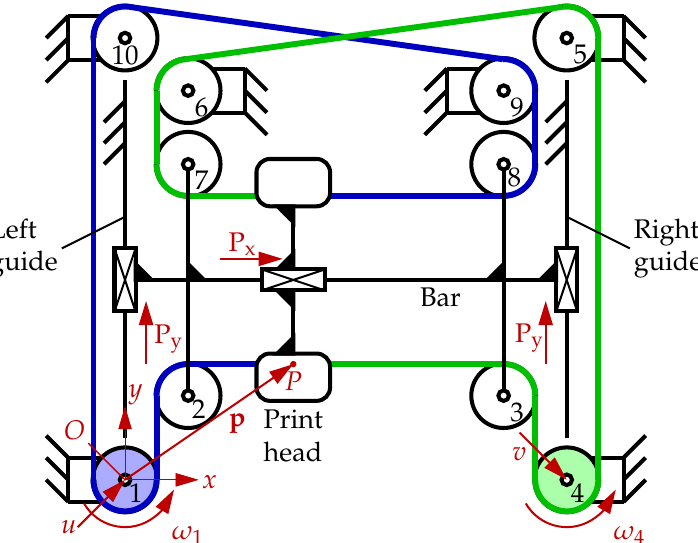
Figure 4. Schematic of a CoreXY routing (top view). For clarity, the two belts are colored; each actuated pulley has the color of the corresponding belt (again, pulleys 1 and 4 are actuated).